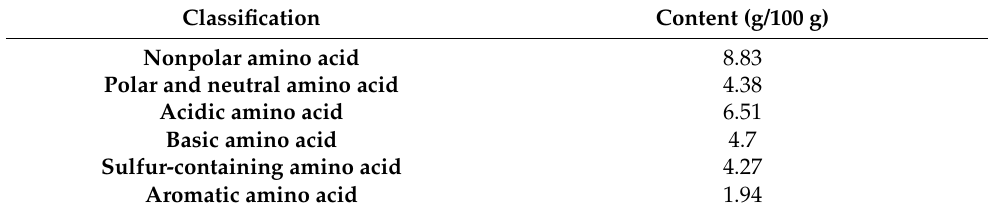
Table 2. Amino acid classification of PPPT.